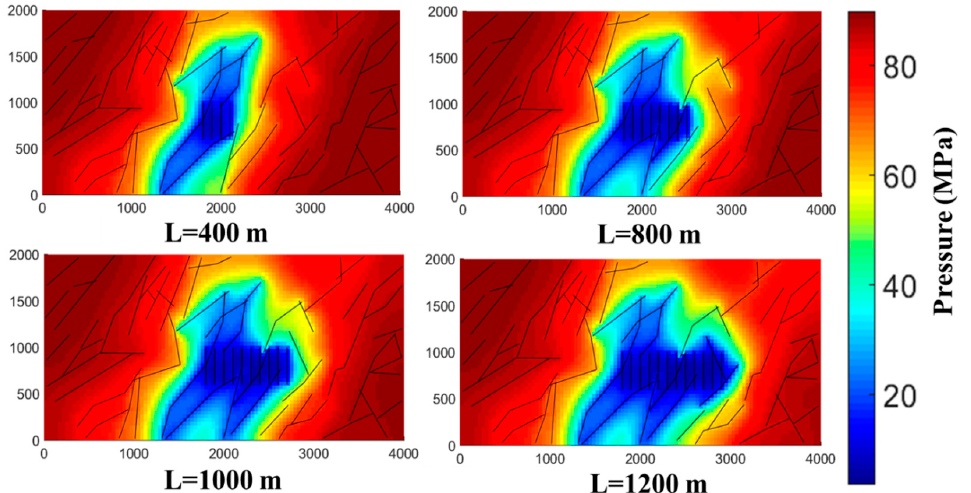
Figure 17. Schematic diagrams of pressure-drop vulnerability distribution at the end of the prediction period for different horizontal length models.